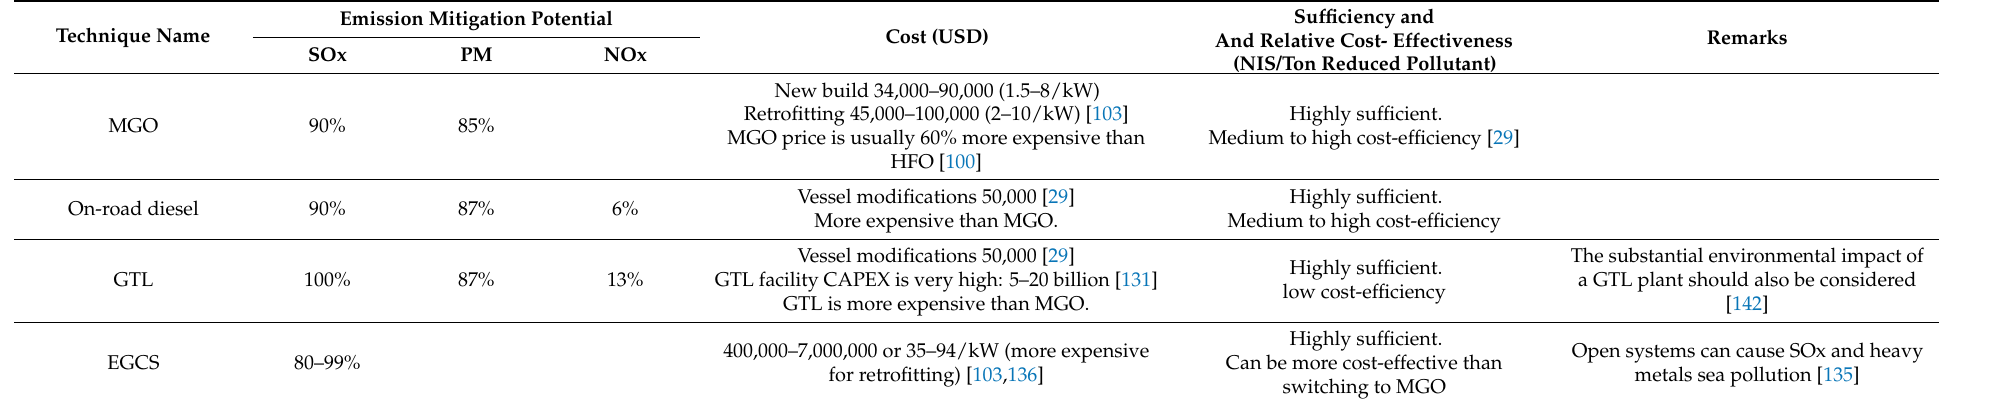
Table A34. SOx mitigation